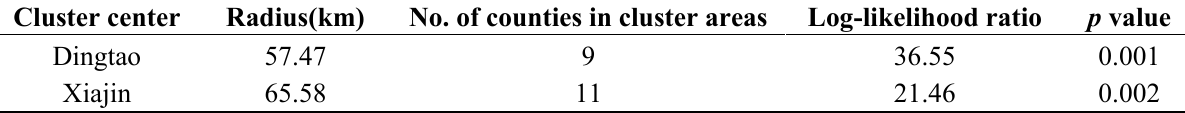
Table 2. Two clusters detected by spatial scan statistic.